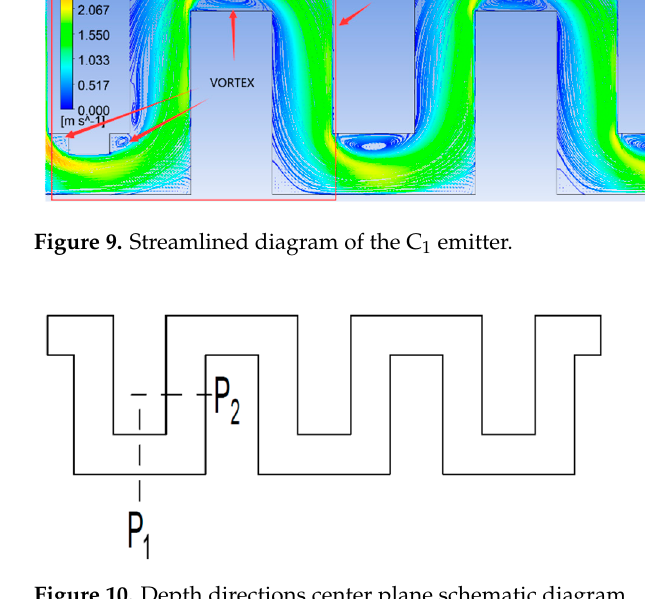
Figure 10. Depth directions center plane schematic diagram.